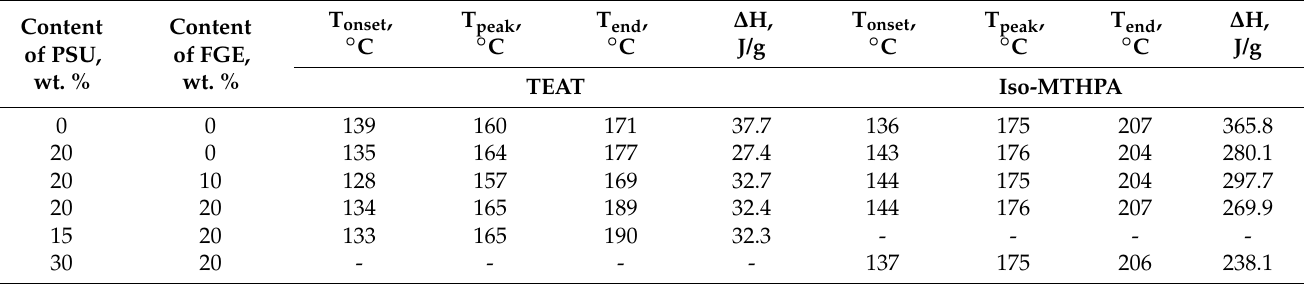
Table 1. Thermal effect ∆ H and temperatures of the onset T onset , peak T peak , and end T end of the curing reaction of the modified epoxy resin.